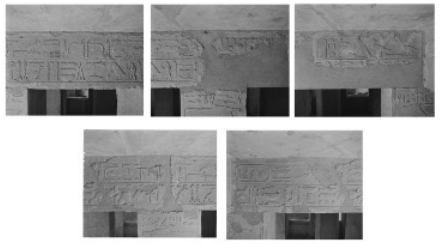
Figure 8 . Photograph of architrave from 1986.